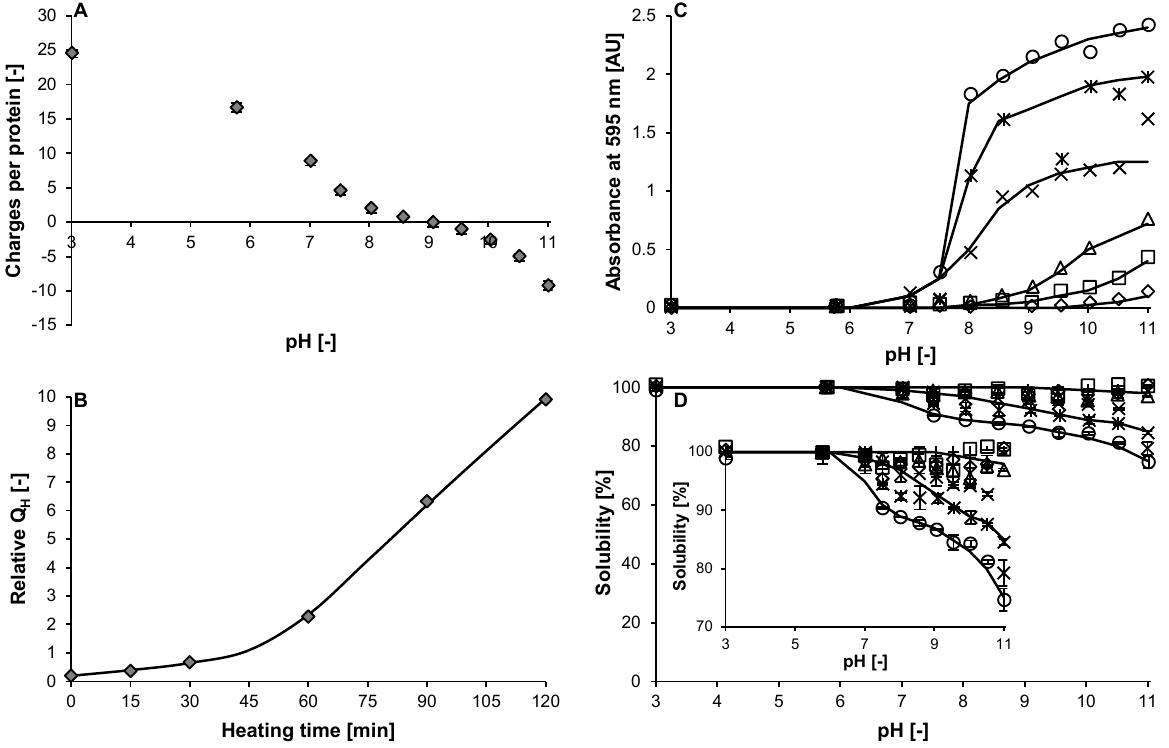
Figure 2. Effect of heating at 77 °C on the number of charges per lysozyme molecule as a function of pH ( A ), the relative exposed hydrophobicity (Q H ) as function of heating time ( B ), and the turbidity ( C ) and solubility ( D ) as function of pH for (un-)heated lysozyme; 0–120 min ( ), 0 ( ), 15 ( ), 30 ( ), 60 ( ), 90 ( ), and 120 min ( —10 mM sodium phosphate buffer pH 5.7). The error bars in panel A indicate the standard deviation. The solid lines in panel B–D are guides to the eye. The insert in panel D shows the data with rescaled y -axis.